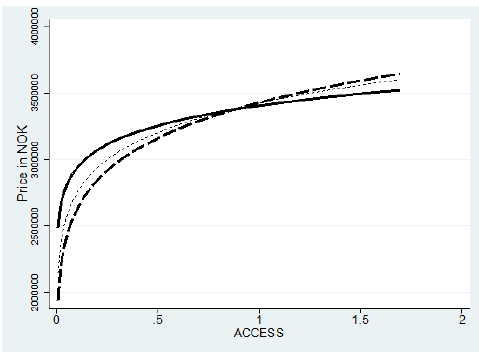
Figure 5: The variable ln MCT is included in the semi-parametric smooth function